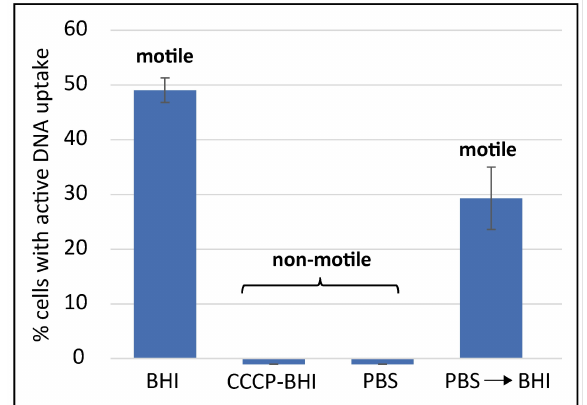
Figure 2. DNA uptake requires proton motive force. Competent C. jejuni pre-incubated for 10 min in the presence of the protonophore CCCP or nutrient-depleted for 2 h in PBS showed abolished DNA uptake capacity and motility. Re-energized cells (PBS → BHI; 2 h in PBS shifted to BHI during DNA uptake) regained motility and the ability to take up DNA. Experiments were performed at least three times. Error bars indicate standard deviation. PBS, phosphate-buffered saline; BHI, brain heart infusion; CCCP, carbonyl cyanide m-chlorophenyl